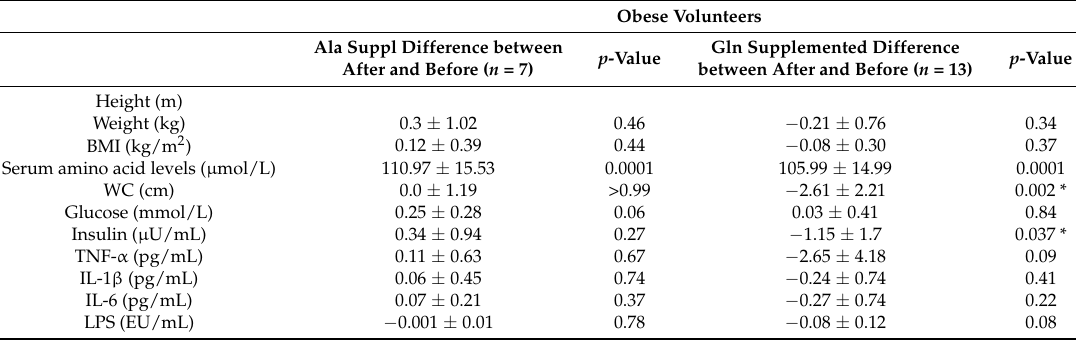
Table 2. Differences in metabolic characteristics of obese volunteers before and after supplementation with glutamine or alanine.